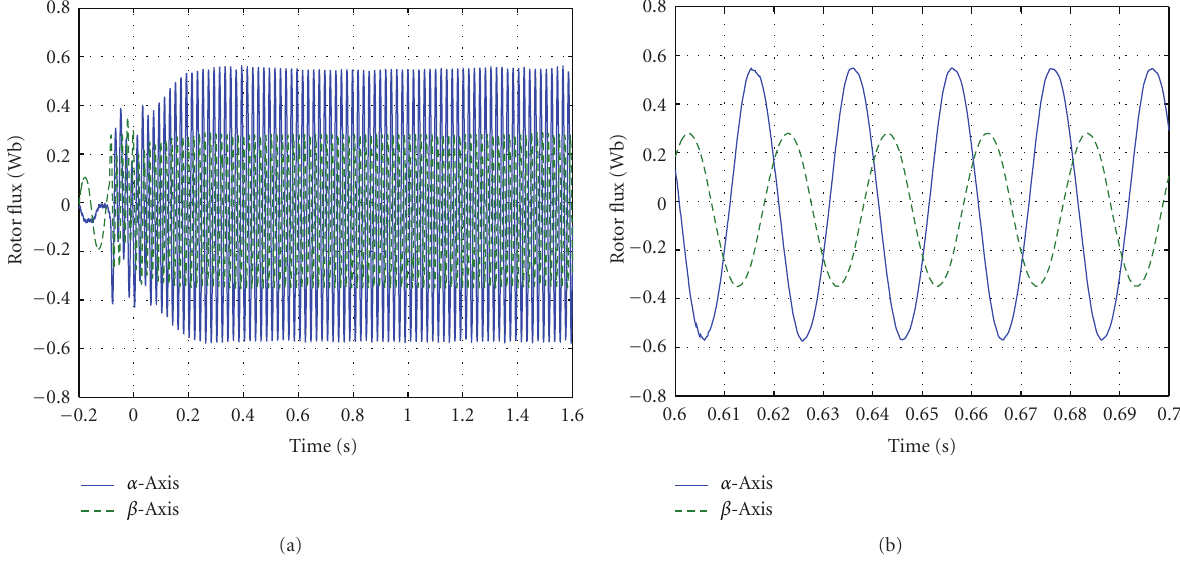
Figure 13: Estimated rotor fluxes λ r of the SPIM during the step from 10 to 50 Hz in the frequency stator (experimental results): (a) estimated rotor fluxes, (b) details of the estimated rotor fluxes at 50